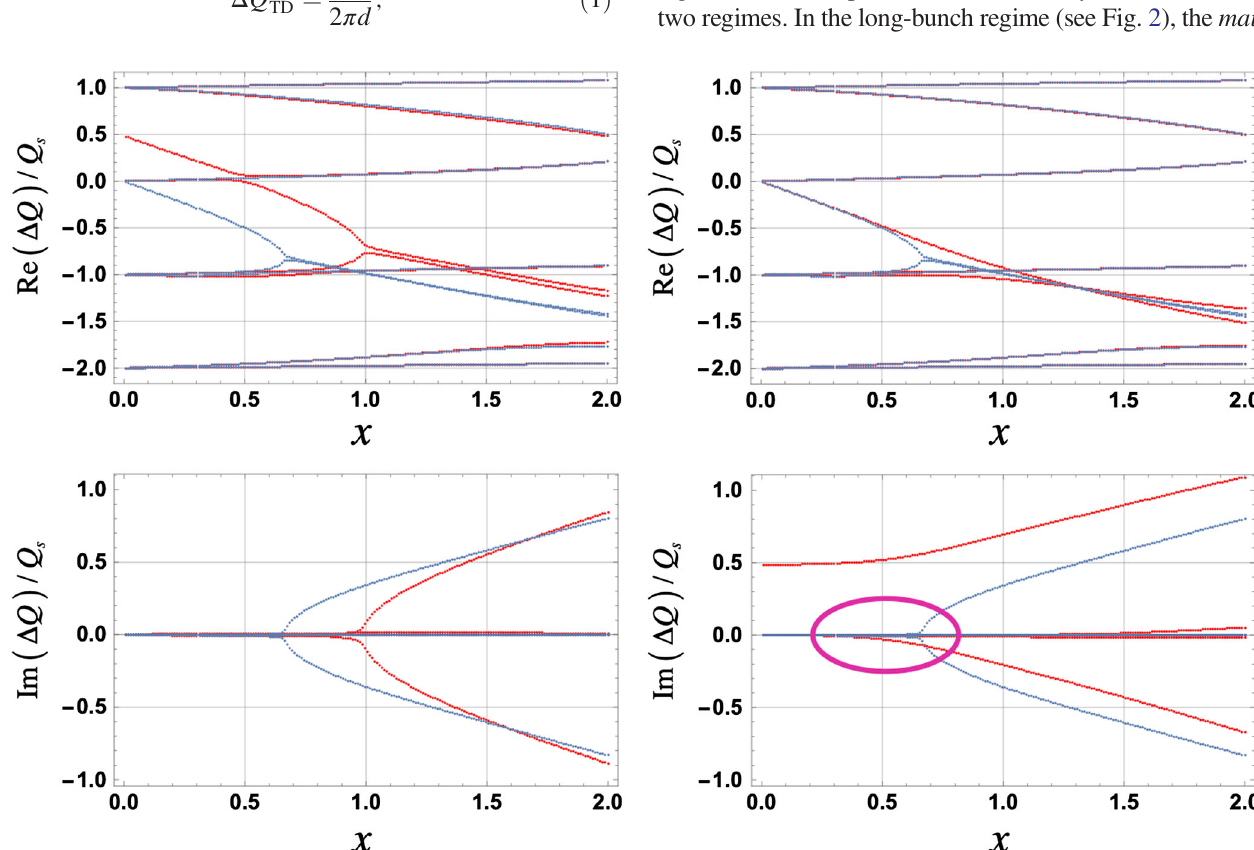
FIG. 3. Same as Fig. 2 but with f r τ b ¼ 0 . 8 (short-bunch regime). This approximately describes the CERN LHC